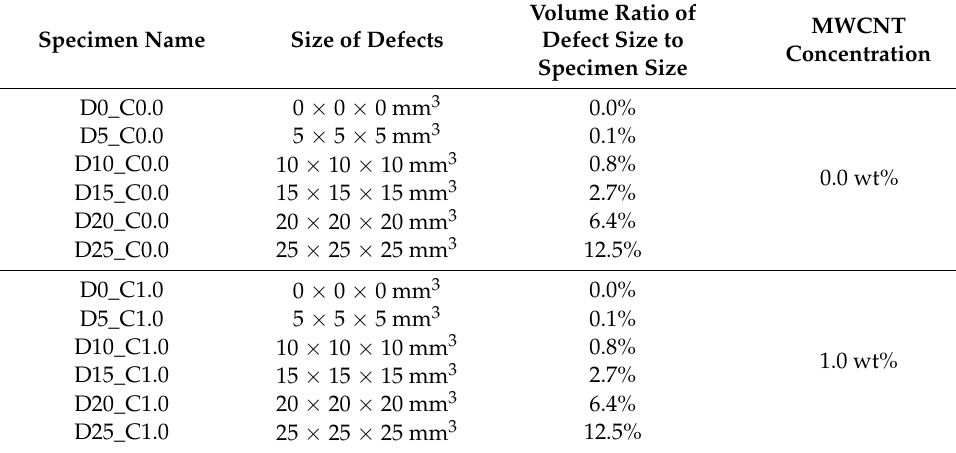
Table 1. Specimen names and experimental parameters.